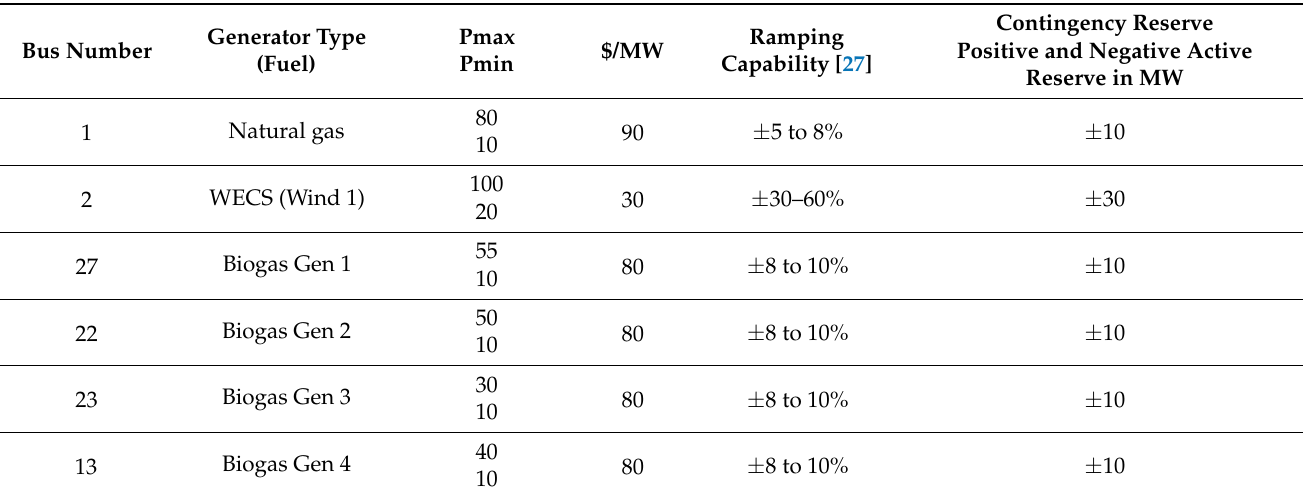
Figure 11. Typical load profile for Pune, India [26]. Table 1. Data for generators.